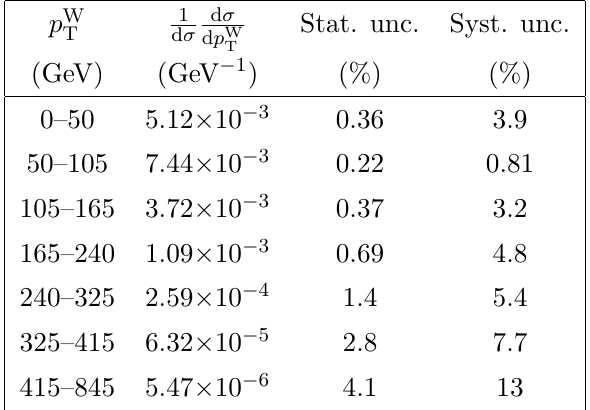
Table 8 . Results of the normalised di(cid:11)erential cross sections with relative uncertainties in the combined channel with respect to p W T